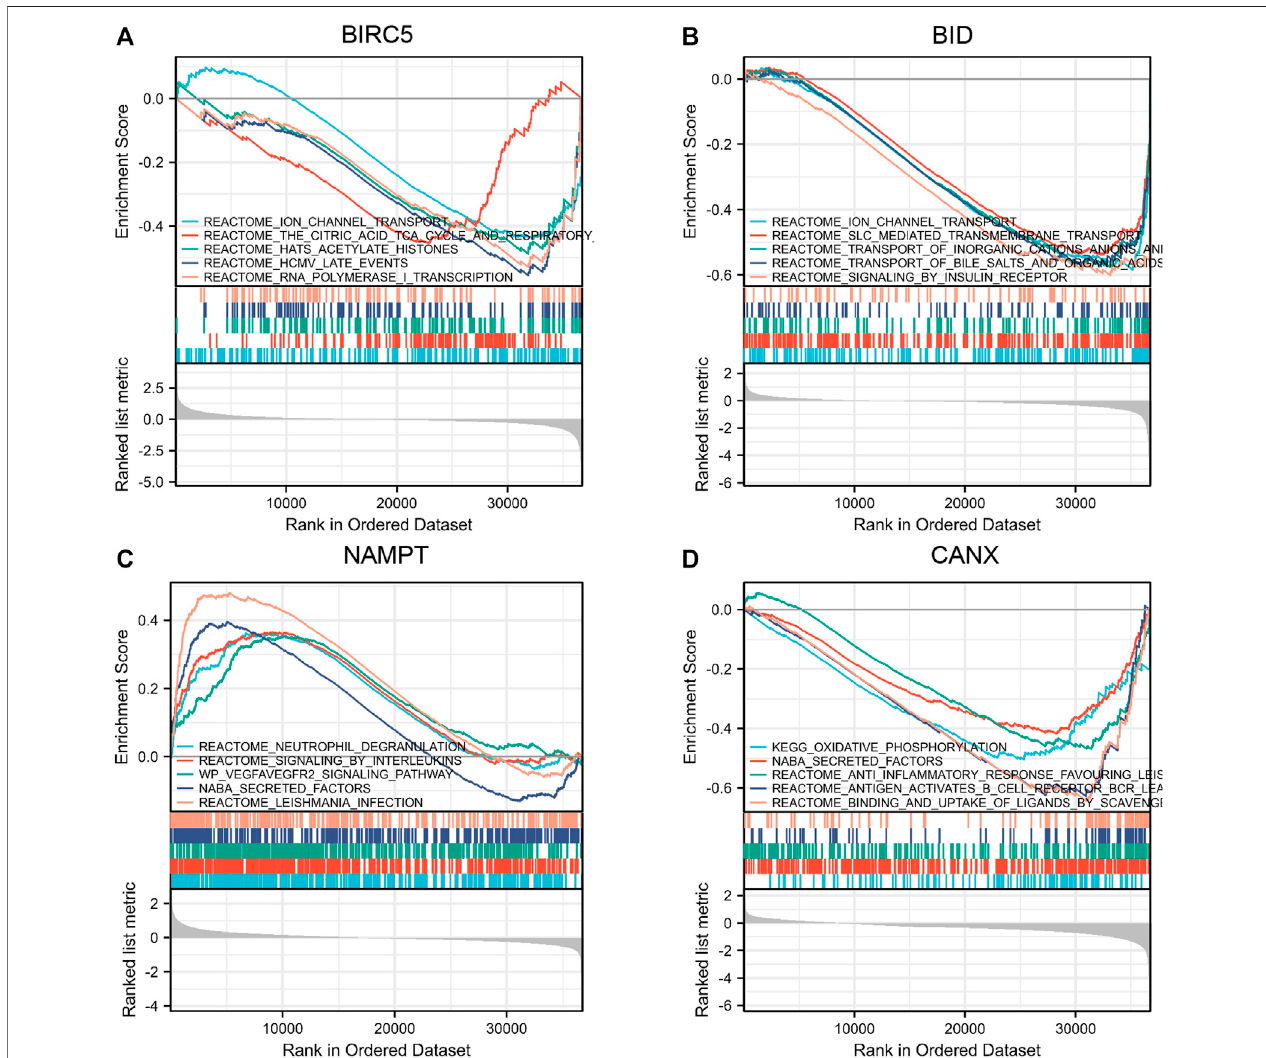
FIGURE 6 | Gene Set Enrichment Analysis (GSEA) of immune-autophagy-related differentially expressed genes (DEGs). Single gene enrichment analysis of BIRC5 (A) , BID (B) , NAMPT (C) , and CANX (D) .